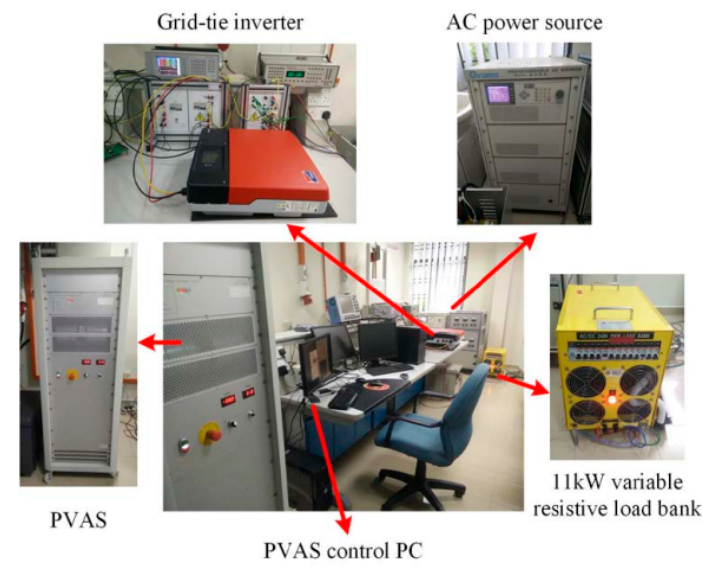
Figure 7. Block diagram of the PV inverter test.